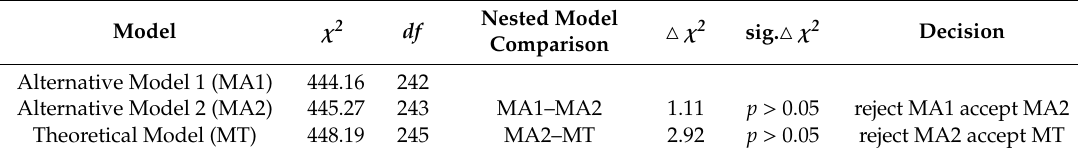
Table 5. Comparison between Alternative and Theoretical